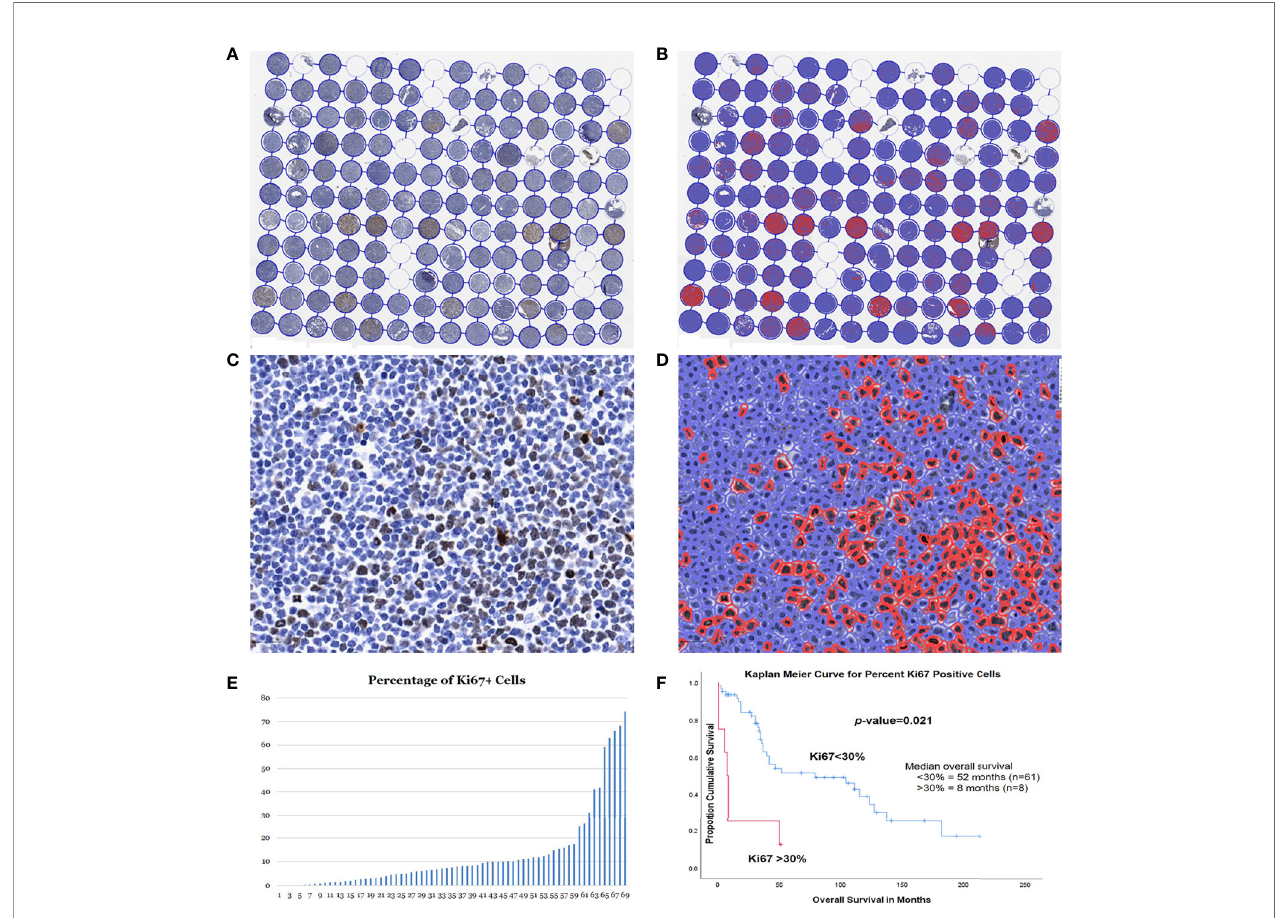
FIGURE 5 | Assessment of Ki67 proliferation rates using QuPath DIA. Whole TMA image with Ki67 immunostain before (A) and after (B) cell detection and positive cell detection. High magni fi cation of a case before (C) and after (D) cell detection and positive cell detection. (E) Dynamic percentage range of Ki67 proliferation rates of the 73 MCL cases. (F) Kaplan-Meier curves for optimal cut-point for patients with high (>30%) vs . low (<30%) Ki67 proliferation